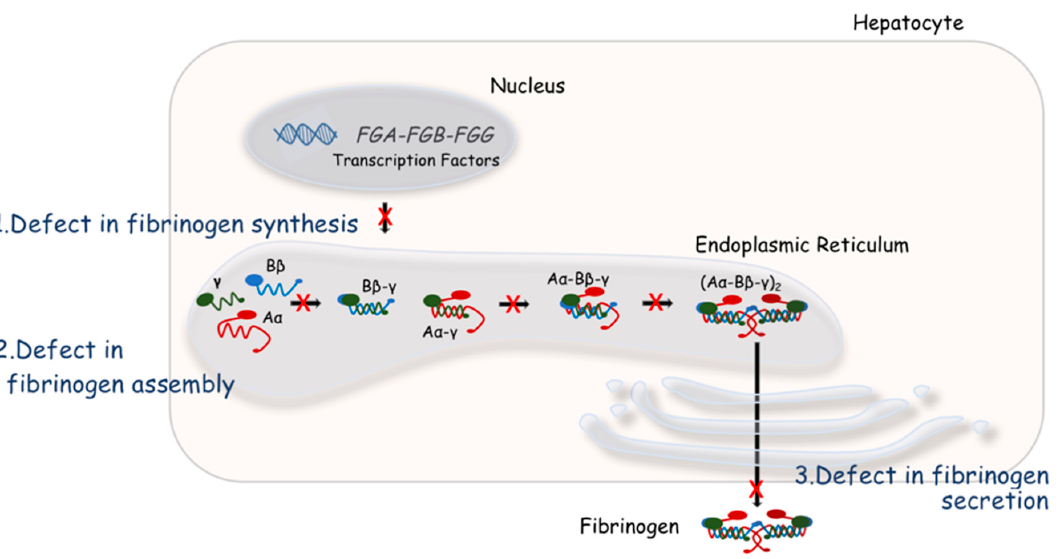
Figure 1. Fibrinogen synthesis in hepatocytes. Fibrinogen synthesis is regulated by both transcriptional and translational mechanisms. After individual fibrinogen chains are translated, fibrinogen assembly proceeds in the lumen of the endoplasmic reticulum in a stepwise manner. Single chains are first assembled to form B β - γ and A α - γ intermediates, then A α -B β - γ half-molecules, and finally the hexameric glycoprotein (A α -B βγ ) 2 . Quantitative fibrinogen disorders can result from defects in synthesis, assembly, or secretion of fibrinogen in circulation [3].